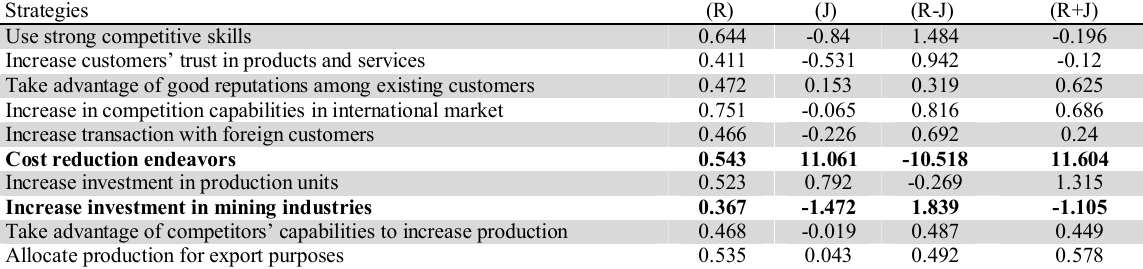
The summary of appropriate